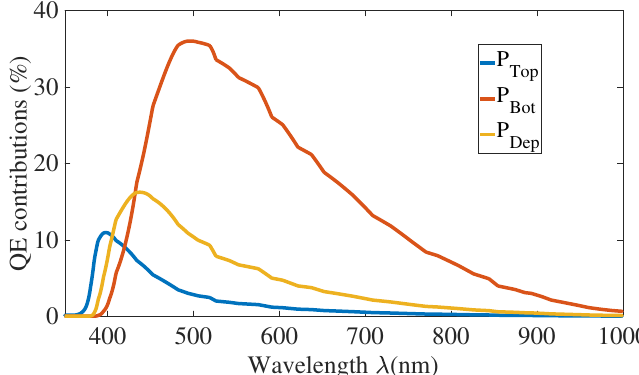
Figure 9. Internal quantum efficiency contributions for V Ex = 20% V Br .